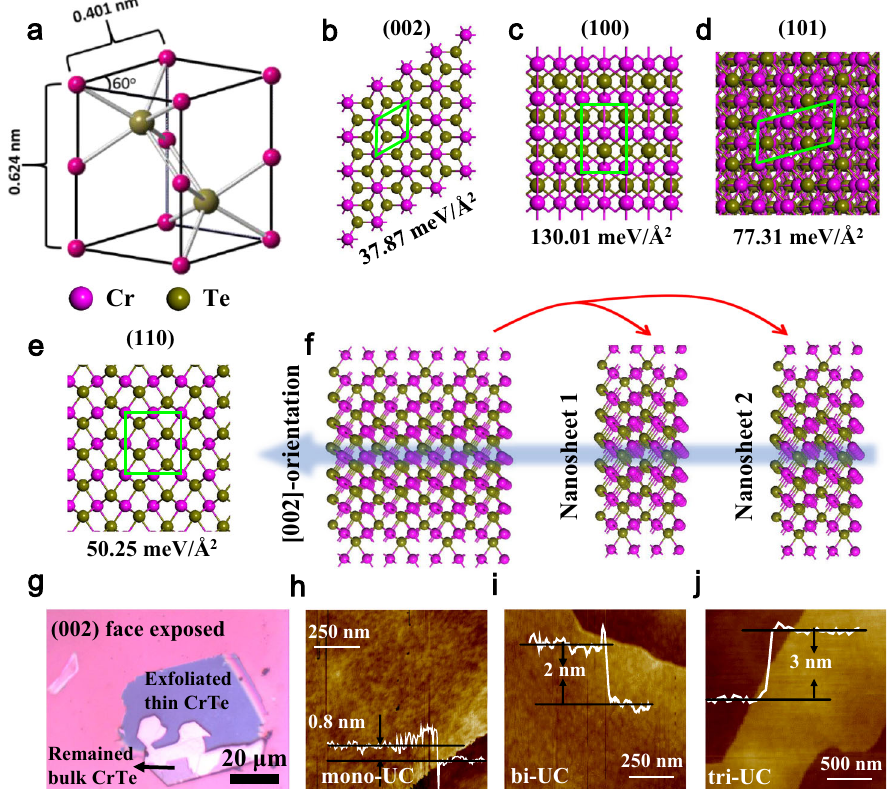
Fig. 1 Exfoliation of the non-van der Waals CrTe crystals by CVD-assisted ultrasonication. a Unit cell of NiAs-tape CrTe. The purple and brown balls represent Cr and Te atoms, respectively. b – e The surface structures and calculated exfoliation energies E ex (in meV/Å 2 ) of four CrTe crystal faces: b (002), 37.87 meV/Å 2 ; c (100), 130.01 meV/Å 2 ; d (101), 77.31 meV/Å 2 ; and e (110) 50.25 meV/Å 2 . The green frames in ( b – e ) denote the range of unit cell. f Mechanism diagram of the cleavage direction for CrTe crystal. g A (002) face exposed bulk CrTe crystal on a SiO 2 /Si substrate that been mechanically exfoliated easily by a Scotch tape, indicating a small cleavage energy of (002) face. h – j AFM images for mono-UC, bi-UC, and tri-UC 2D CrTe crystals obtained by CVD-assisted ultrasonication with different thicknesses of 0.8 nm (mono-UC), 2 nm (bi-UC), and 3 nm